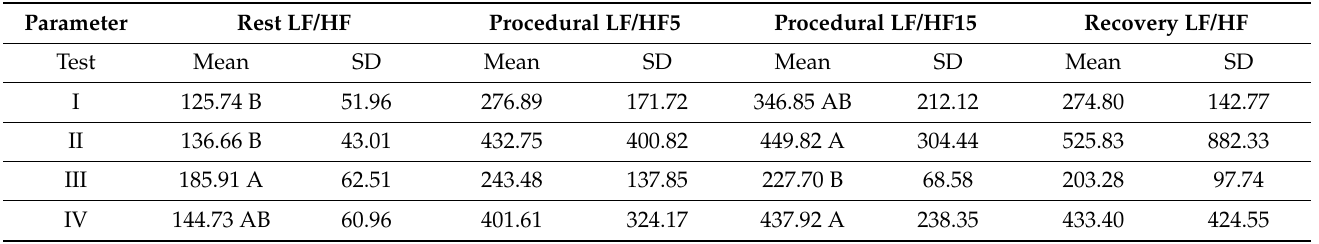
Table 8. LF/HF (low-frequency spectrum power to high-frequency spectrum power ratio) during consecutive tests.